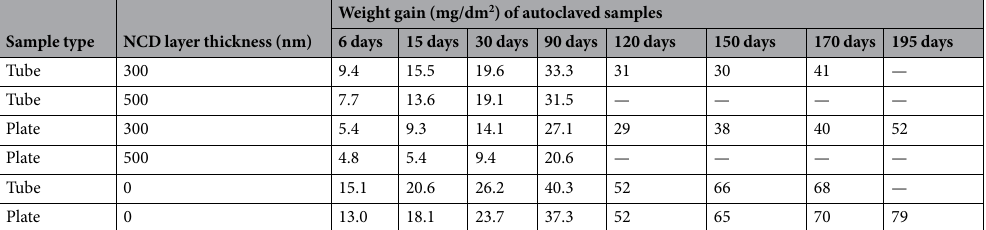
Table 1. Weight gains (mg/dm 2 ) measured after autoclave tests of uncoated ZIRLO samples (tubes and plates) and samples coated with 300 or 500 nm of NCD. The samples were processed in 360 °C hot water for 6, 15, 30, 90, 120, 150, 170, and 195 days under primary circuit conditions in a PWR in accordance with ASTM standard procedures 21 . The greater relative weight gain of the uncoated ZIRLO plates and tubes indicated stronger oxidation of the unprotected